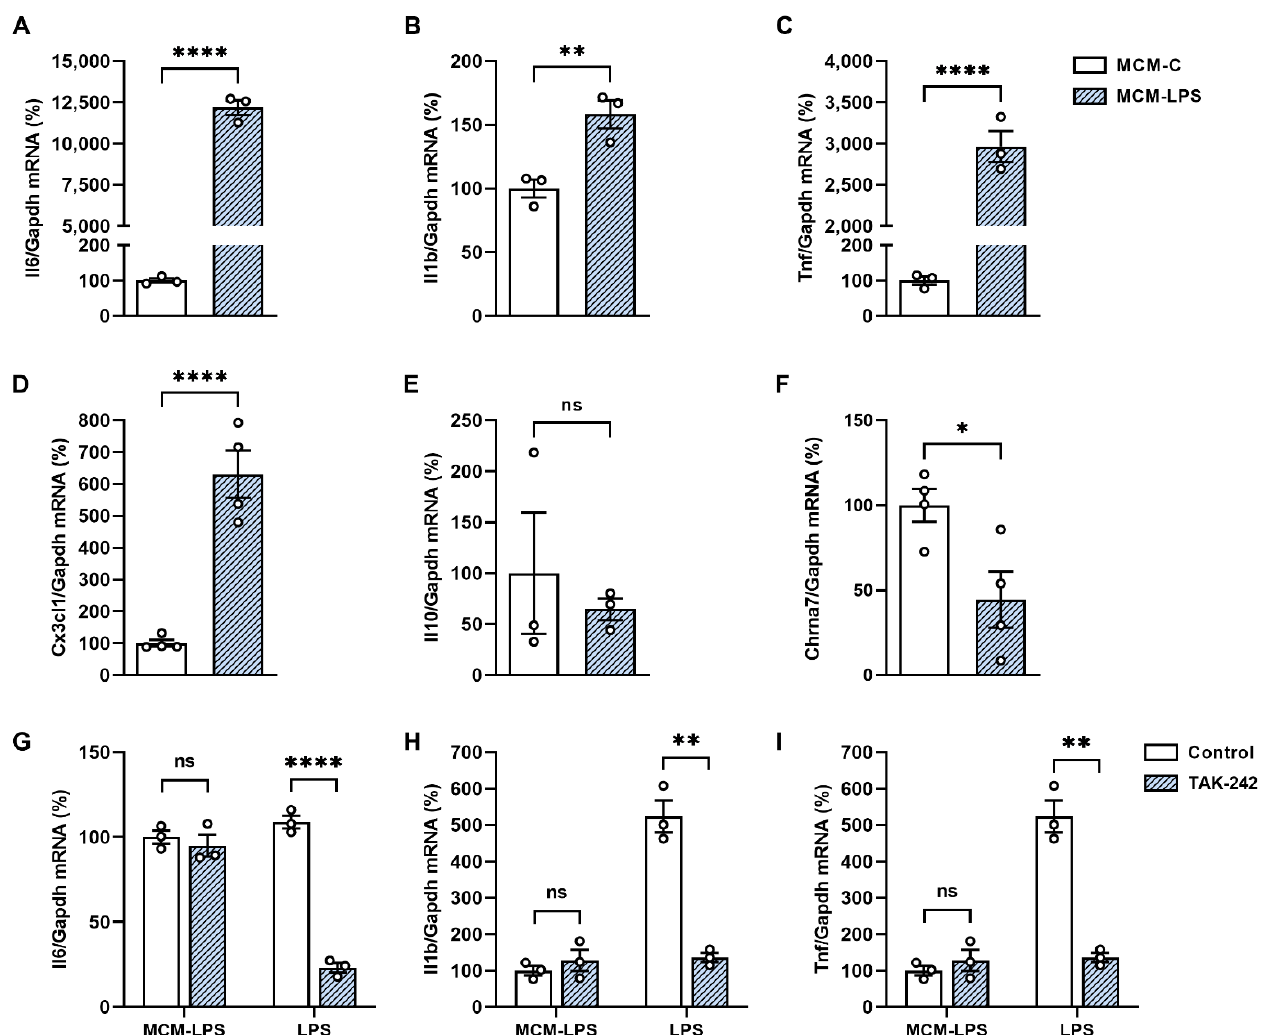
Figure 3. Microglial conditioned medium induces inflammation in neuronal cells. ( A – F ) mHypoA- 2/29 immortalized neuronal cells were incubated for 6 h with microglial conditioned medium obtained from control BV-2 cells (MCM-C) or cells previously treated with LPS (MCM-LPS) and mRNA expression of the genes encoding ( A ) IL-6, ( B ) IL-1 β , ( C ) TNF- α , ( D ) CX3CL1, ( E ) IL-10, and ( F ) Chrna7 were evaluated by RTq-PCR. ( G – I ) mHypoA-2/29 cells were treated with the TLR4 inhibitor TAK-242 (10 µ M) 1 h before MCM-LPS or LPS treatment and the expression of ( G ) IL-6, ( H ) IL-1 β , ( I ) TNF- α was evaluated by RTq-PCR. * p < 0.05, ** p < 0.01, **** p < 0.0001, n = 3 – 4.